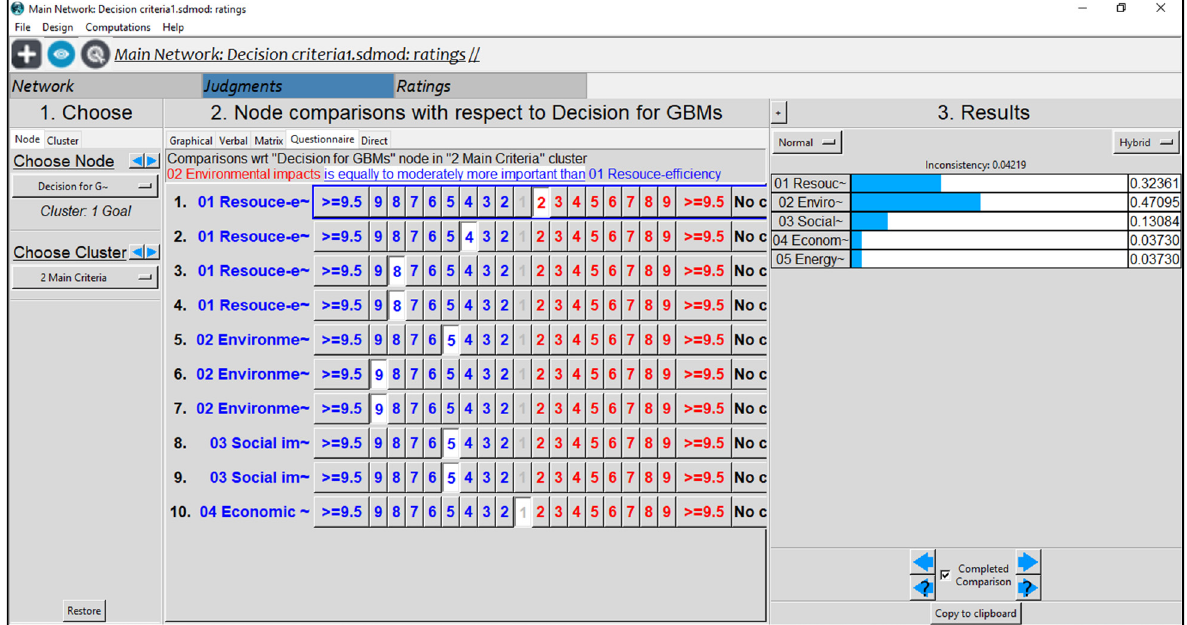
Figure A1. A sample of the pairwise comparison matrix for the main criteria.